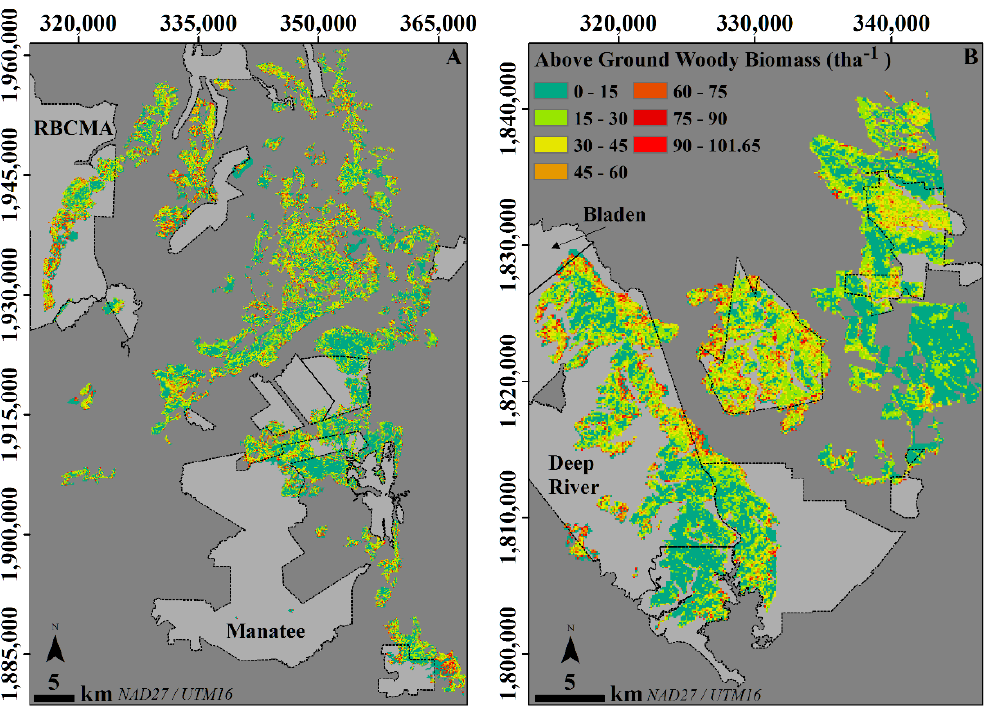
Figure 5. AGWB estimates (MBE 100 ) derived by ALOS PALSAR Scenes I, and II for ( A ) north Belize (Scene I) and ( B ) south Belize (Scene II), overlaid on protected areas boundaries (light grey polygons with dashed lines as boundaries) that contain